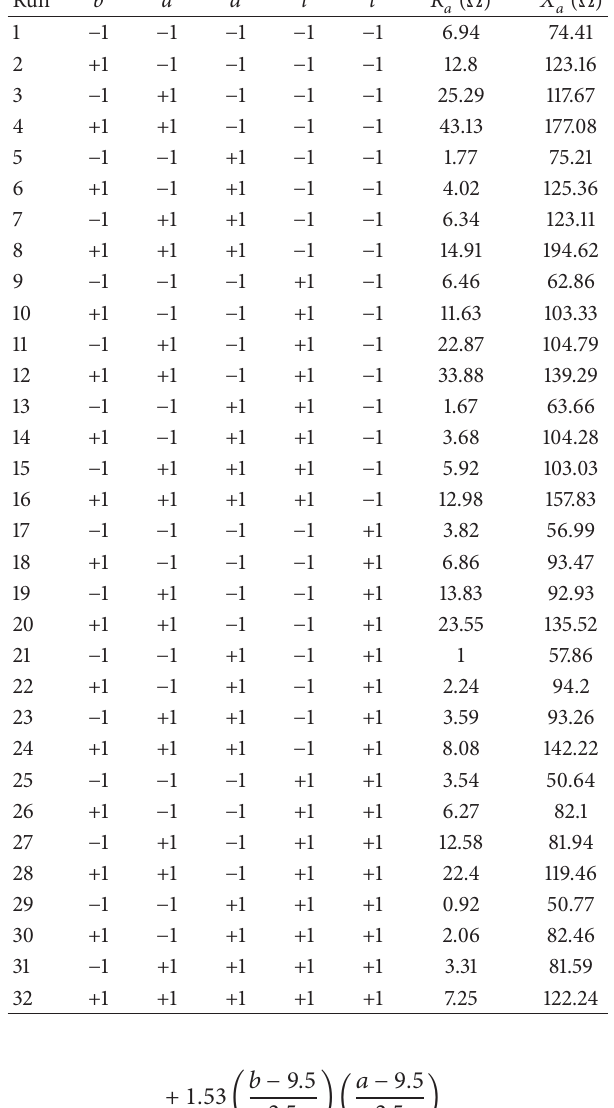
Table 2: The 2 5 full factorial design and the simulated results (at 915